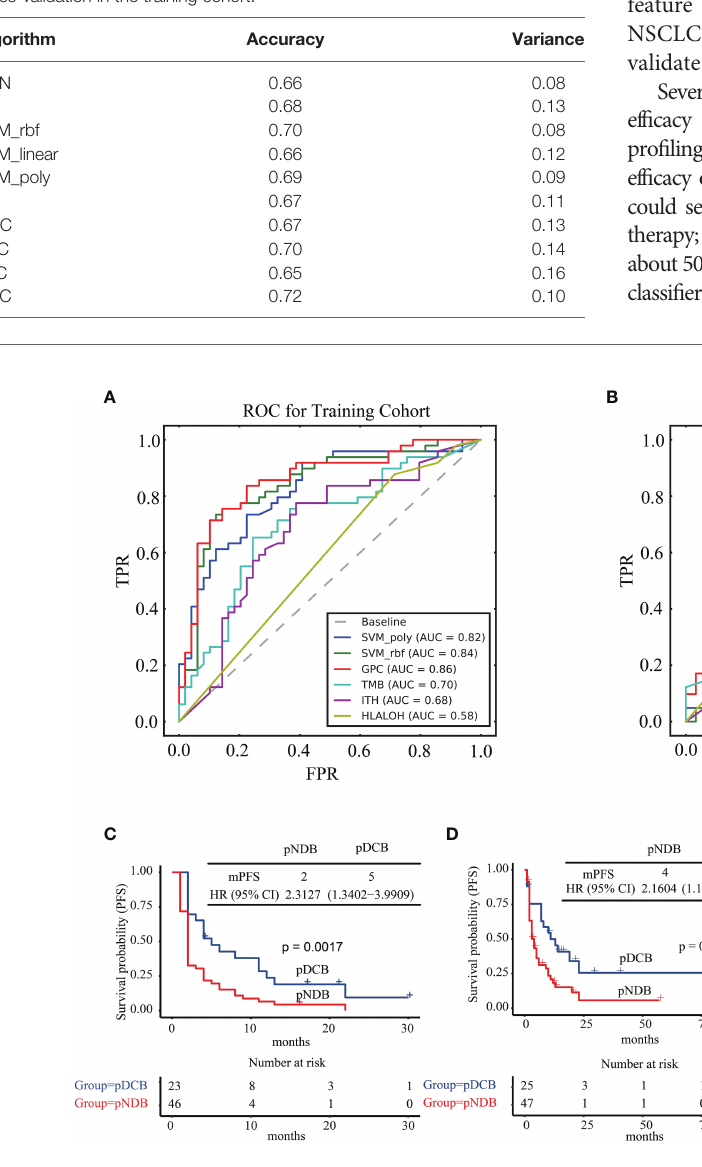
FIGURE 3 | Algorithm selection for multi-feature model construction. (A) ROC curves for SVM_poly, SVM_rbf, GPC, TMB, ITH, and HLA LOH in the training cohort. (B) ROC curves for SVM_poly, SVM_rbf, GPC, TMB, ITH, and HLA LOH in test cohort1. (C) Kaplan – Meier curves of PFS comparing pDCB with pNDB in the training cohort. (D) Kaplan – Meier curves of PFS comparing pDCB with pNDB in test cohort1. (E) Kaplan – Meier curves of OS comparing pDCB with pNDB in test cohort1. pDCB, patients predicted to have durable clinical bene fi t; pNDB, patients predicted to have no durable bene fi t; PFS, progression-free survival; OS, overall survival.